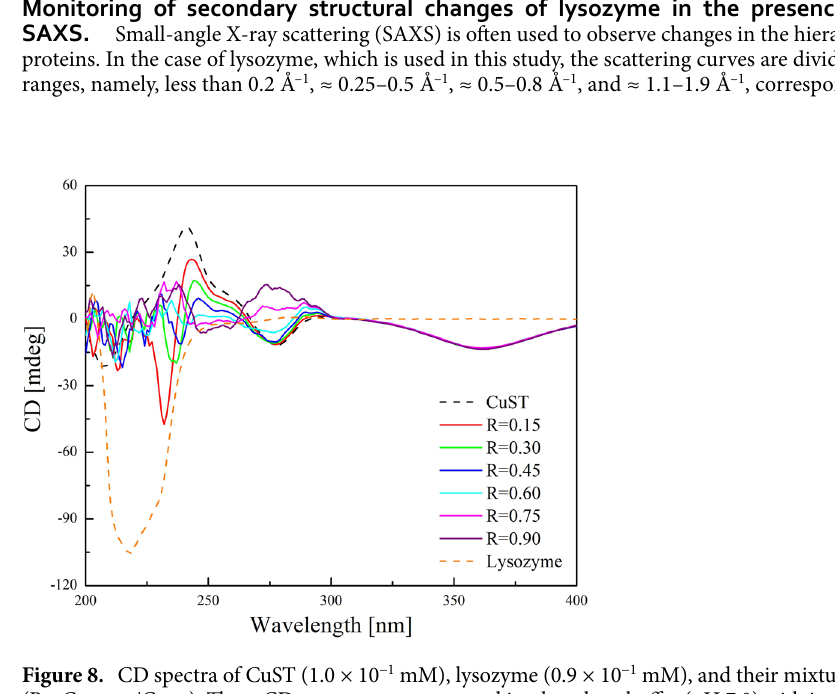
Figure 8. CD spectra of CuST (1.0 × 10 −1 mM), lysozyme (0.9 × 10 −1 mM), and their mixture in various ratios (R = C Lysozyme /C CuST ). These CD spectra were measured in phosphate buffer (pH 7.0) with increasing lysozyme concentration (0–0.9 × 10 −1 mM). A quartz cell (path length: 1.0 cm) was used for the